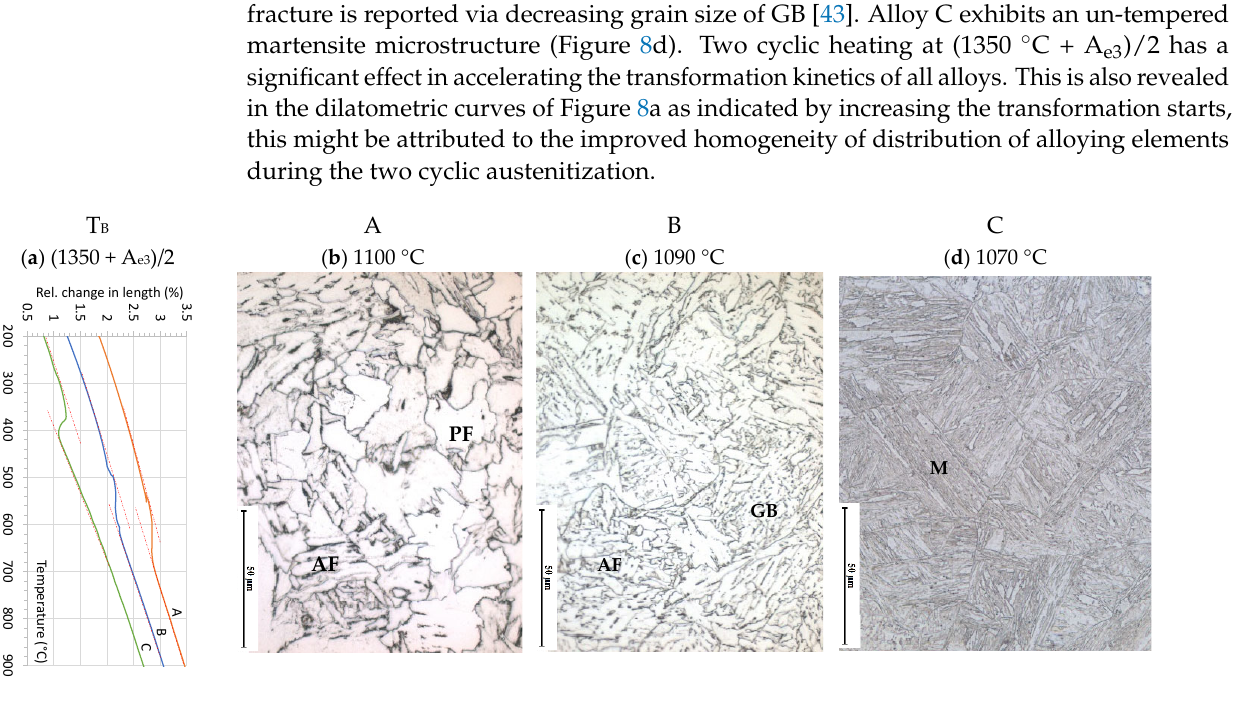
Figure 7. HV 0.025 values together with the micro-hardness indentations ( a ) in GB and ( b ) in WF of the microstructure developed after applying schedule I on alloy A.